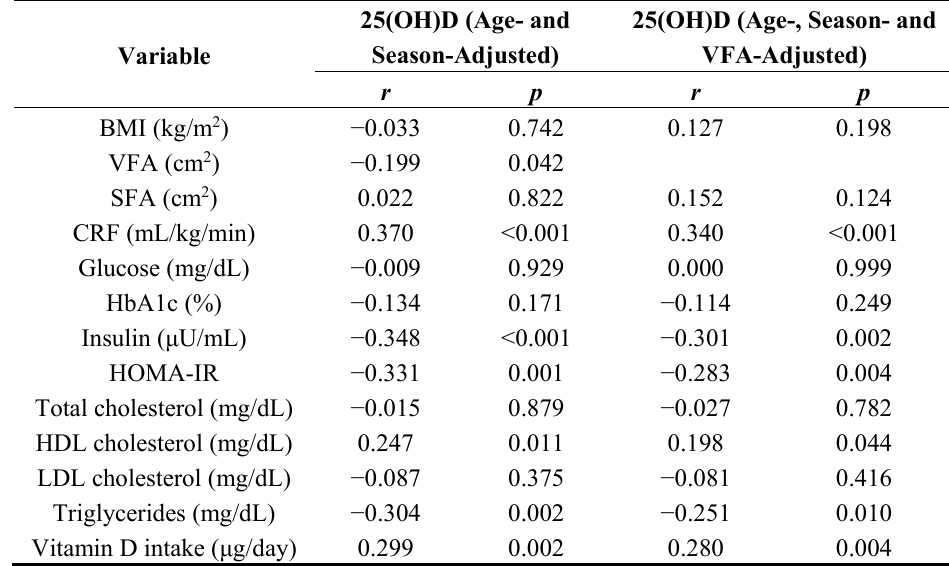
Table 2. Correlations of serum 25(OH)D with subject characteristics in middle-aged and elderly adults.